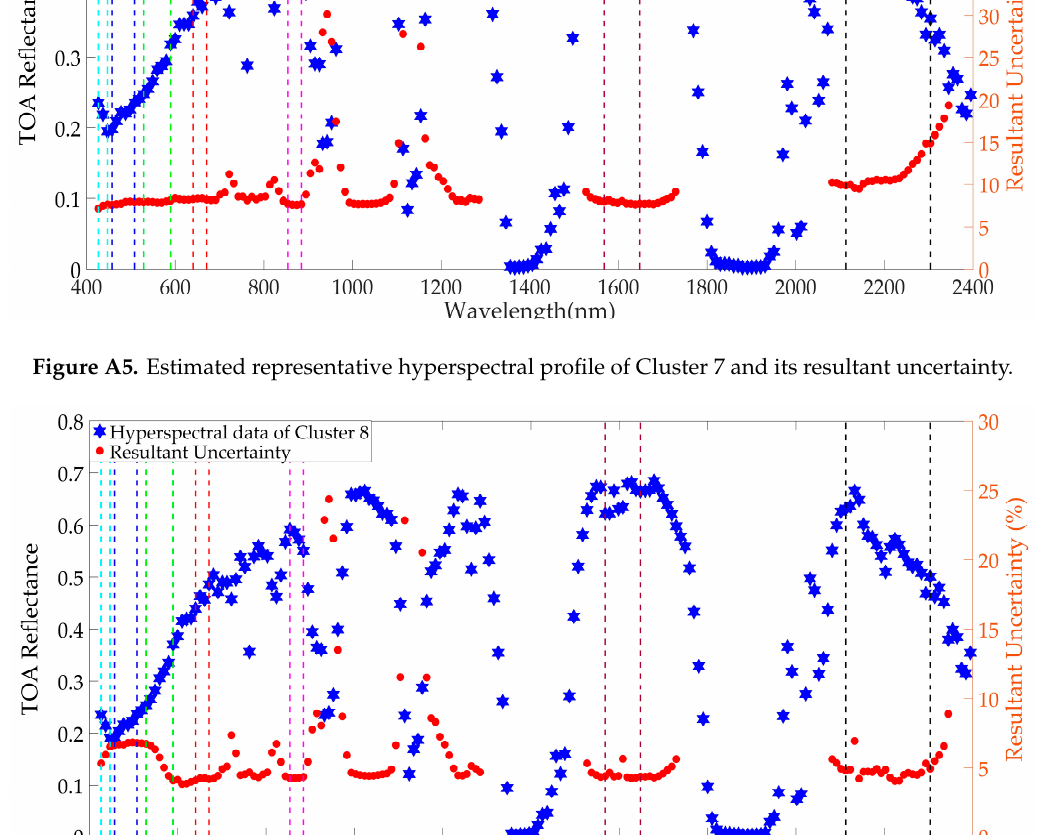
Figure A6. Estimated representative hyperspectral profile of Cluster 8 and its resultant uncertainty.